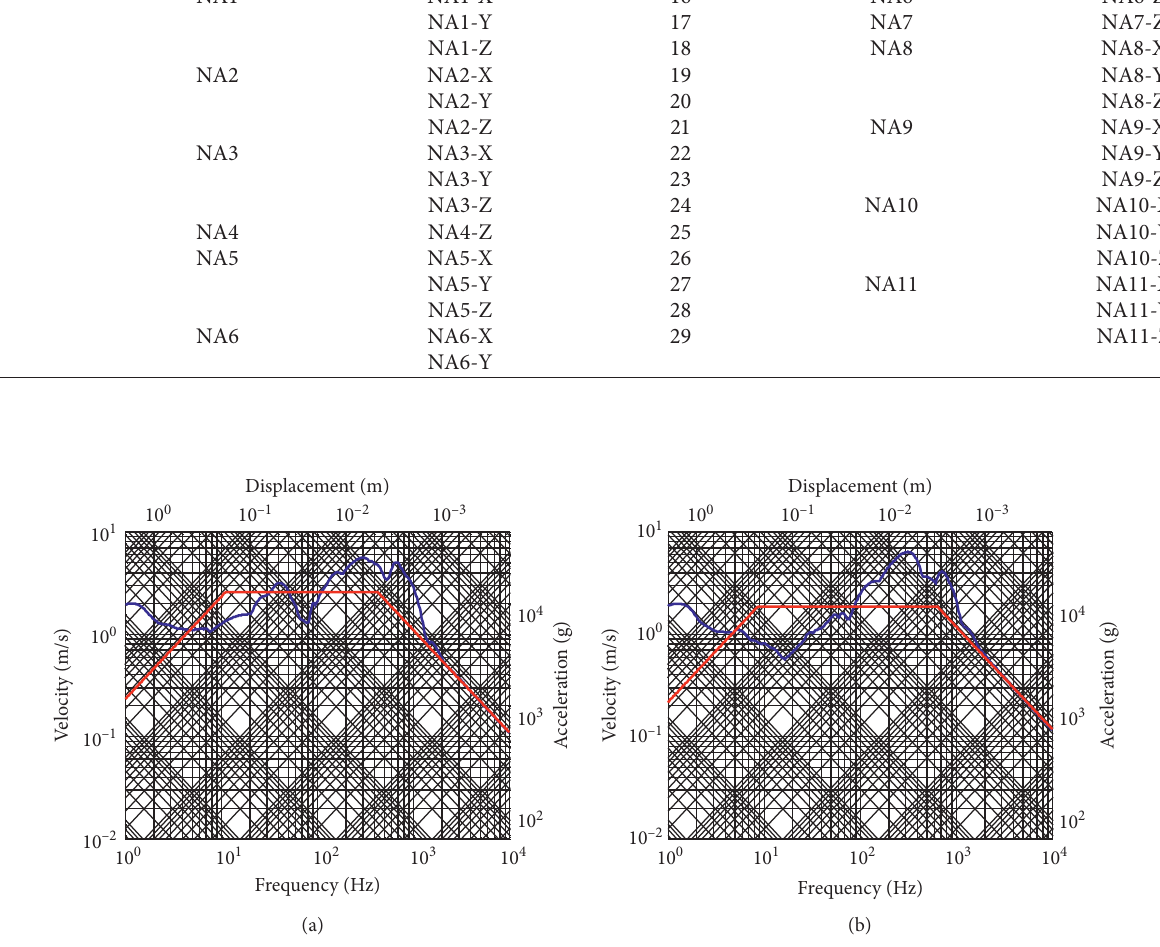
Figure 17: Shock response spectrum and design spectrum of typical channels. (a) Channel 6. (b) Channel 9.